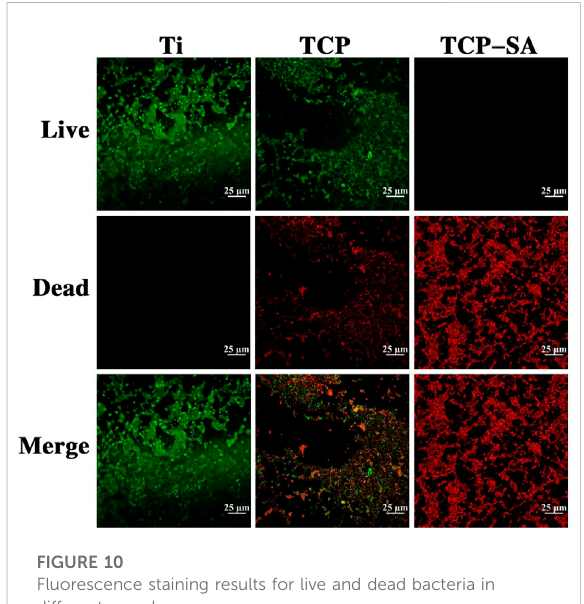
FIGURE 10 Fluorescence staining results for live and dead bacteria in different samples.